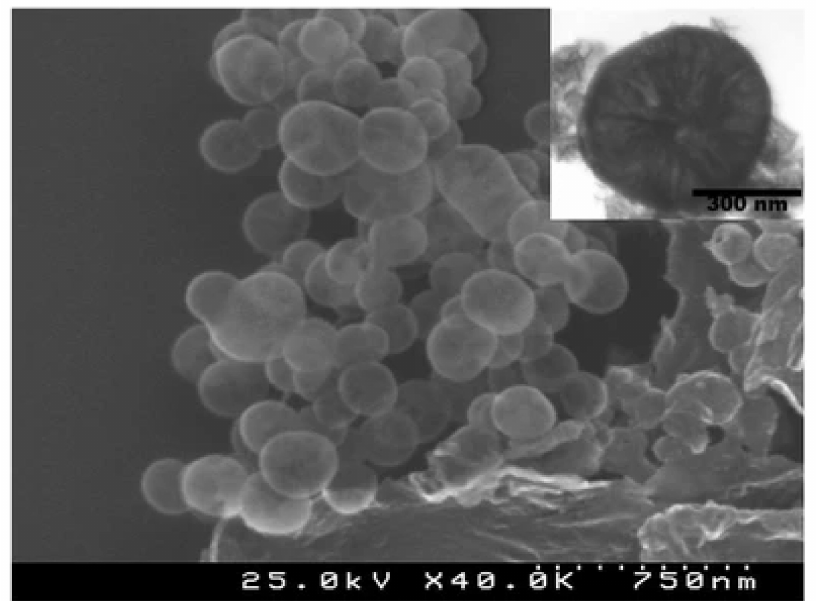
Figure 12. SEM image of mesoporous silica capsules. Inset shows the TEM image of an individual SiNC. Figure derived from the work of Avelelas et al. (Reproduced from [14], published by Springer Nature,